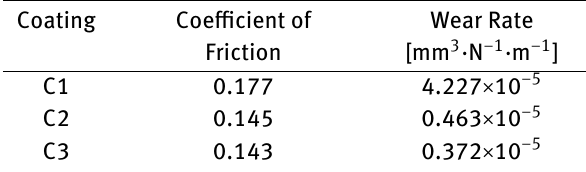
Table 3: COF and wear rates of the coatings Coating Coeflcient